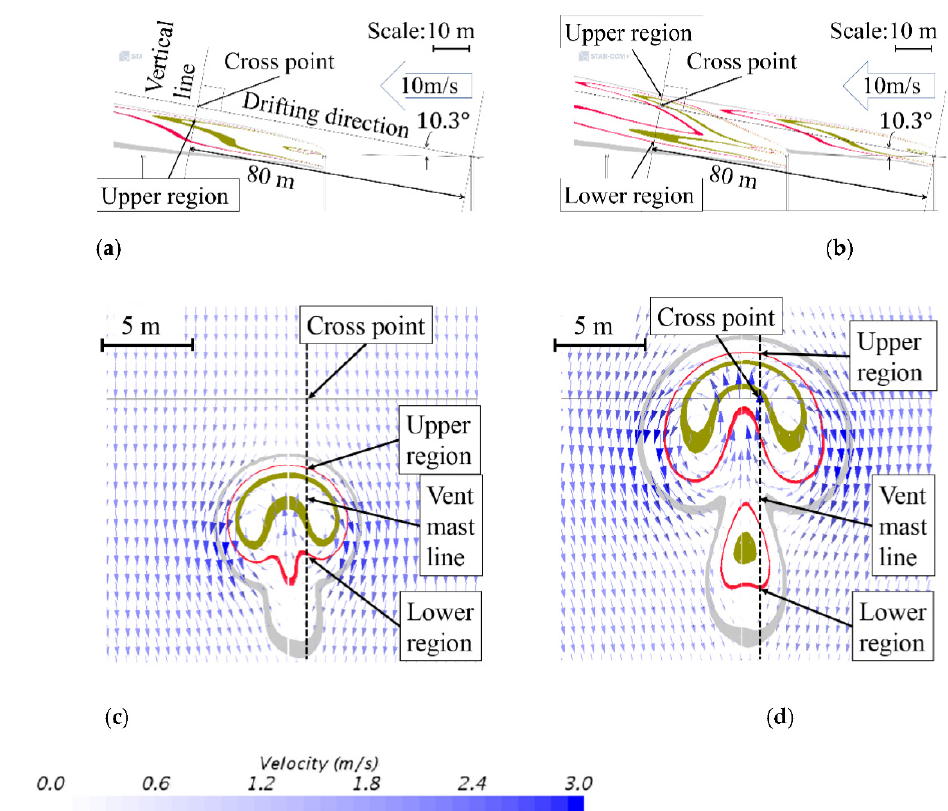
Figure 10. Contour lines of the FL with vectors at the cross section at 80 m drifting distance at a relative wind speed of 10 m/s. The left side of the scene ( a , c ) represents the scenario of emission from the second vent mast alone. The right side ( b , d ) represents the scenario of simultaneous emission from the first and second vent masts. The FL for the cross section of the vent-mast line in ( a , b ) and for the cross section of the vertical line ( c , d ) at a drifting distance of 80 m are shown.